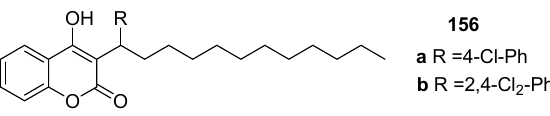
Figure 52. C-3 alkyl coumarin derivatives.